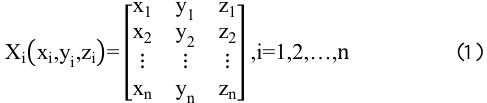
Figure 1. A neighborhood of n = 10 points, k = 9. (Sidiropoulos et al, 2016)